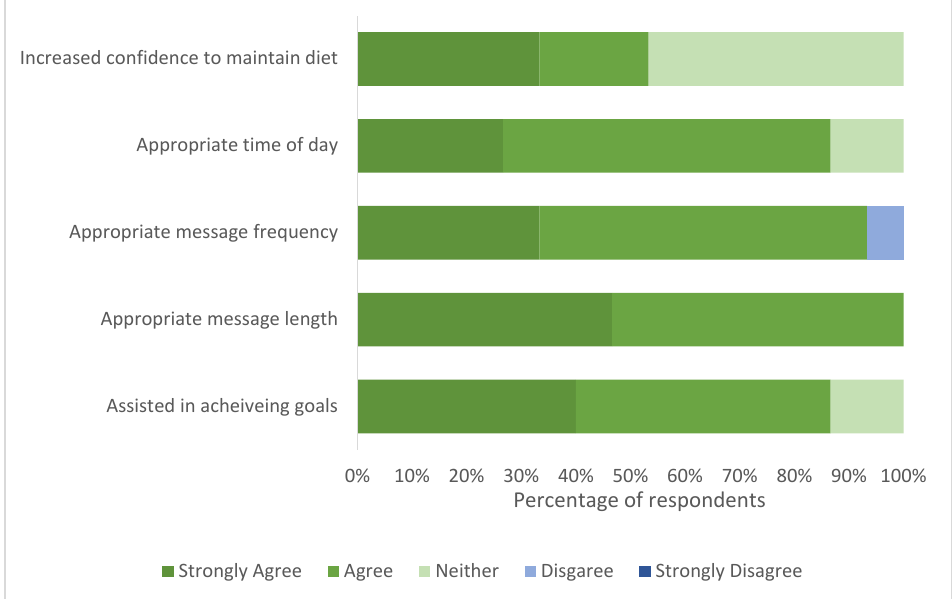
Figure 6. Intervention participant ( n = 15) opinions on the length, frequency, scheduling and benefit of the text message support component of the AusMed diet program.